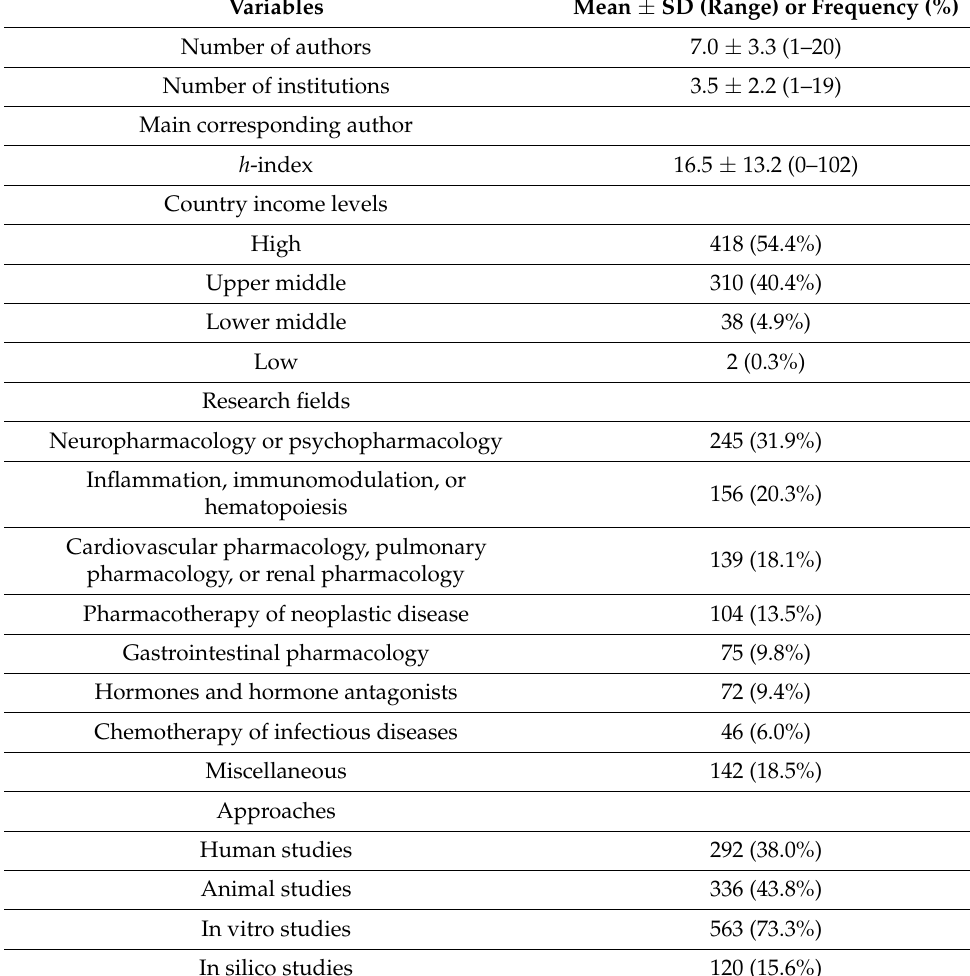
Table 2. Characteristics of the included